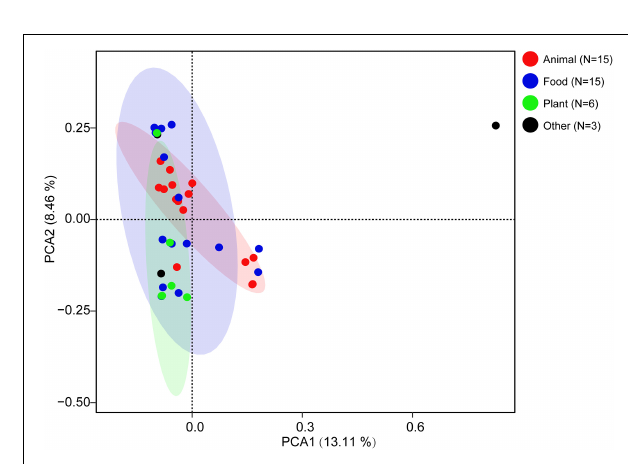
FIGURE 6 | Effects of ecological niches on the genomic characteristics of W. confusa